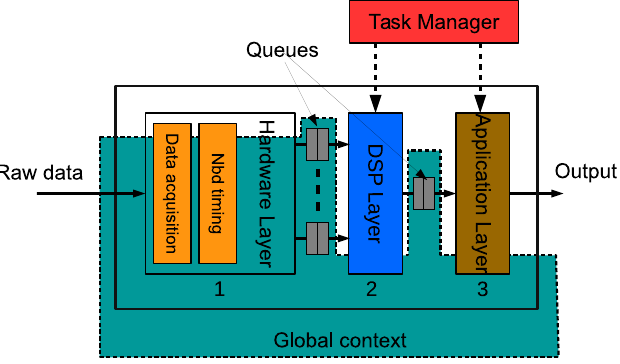
Figure 2. A processing pipeline containing three layers. The pipeline is managed by three main processes (orange and red in the figure). The data acquisition is a synchronous process that periodically samples data guaranteeing that they are delivered to higher layers in the pipeline at a fixed rate. The non-blocking timing is also an synchronous process that updates a list of timers. The third one, the Task Manager, is continuously executing the rest of the layer processes asynchronously. Finally, the global context contains the information that all processes share. The queues, timers and global variables are all defined in this area of the